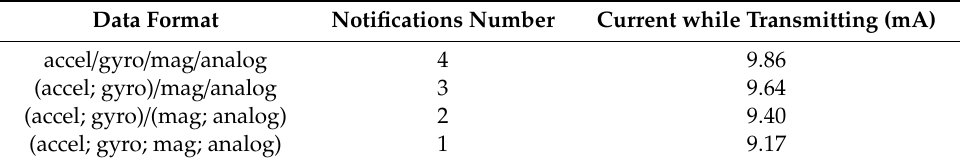
Table 1. Energy Consumption Analysis—Notification Number, the best result is highlighted.